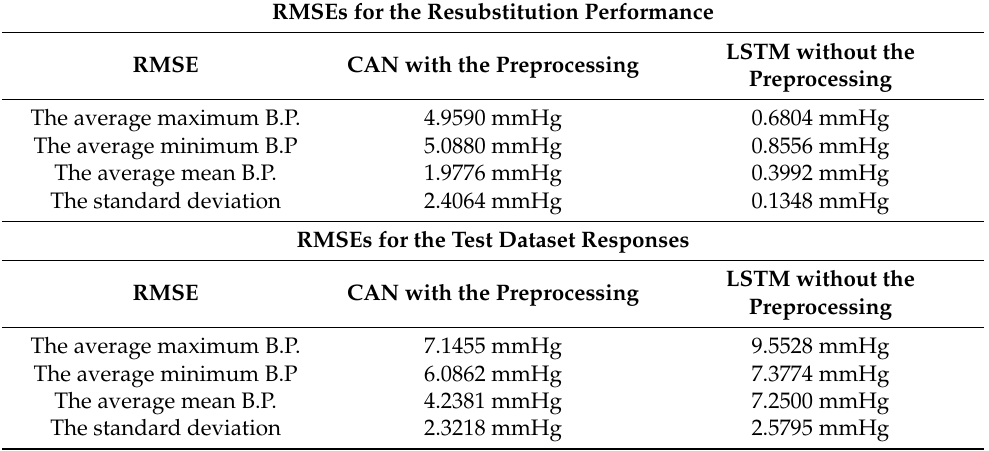
The average maximum B.P.